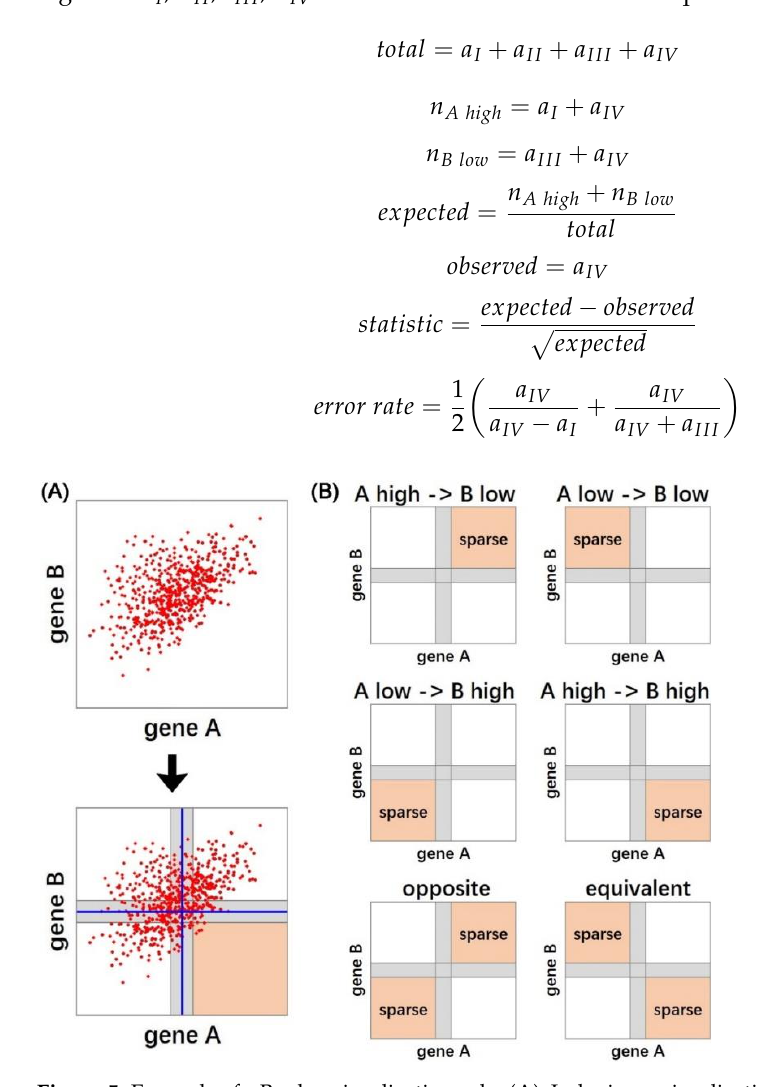
Figure 5. Example of a Boolean implication rule. ( A ). Inducing an implication rule based on quadrants of the categorized expression levels of gene A and gene B. The intermediate areas in gray are removed from the implication rule induction. ( B ). Six specific implication rules connecting gene A and gene B.